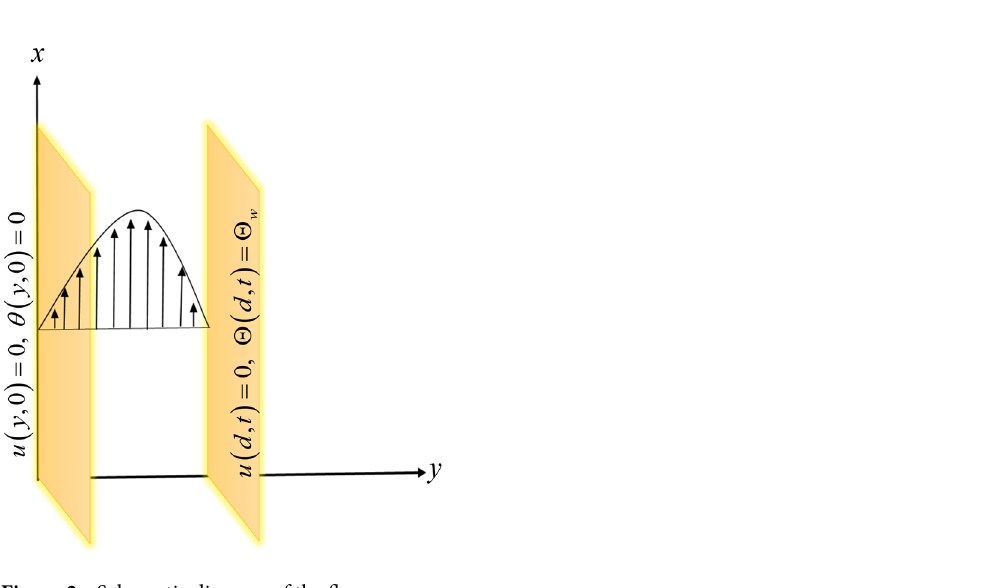
Figure 2. Schematic diagram of the